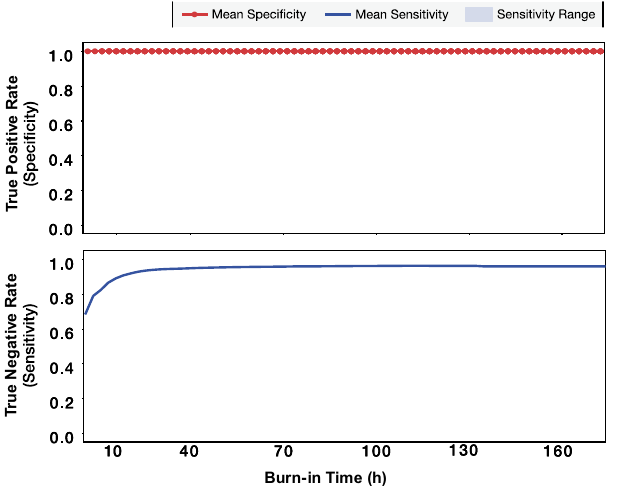
Figure 4. Calculated mean specificity and sensitivity with respect to burn-in time. The blue shaded region indicates the sensitivity range across the 10 different combinations of training and testing data sets. The mean sensitivity of all 10 cases is plotted onto the shaded region as a solid